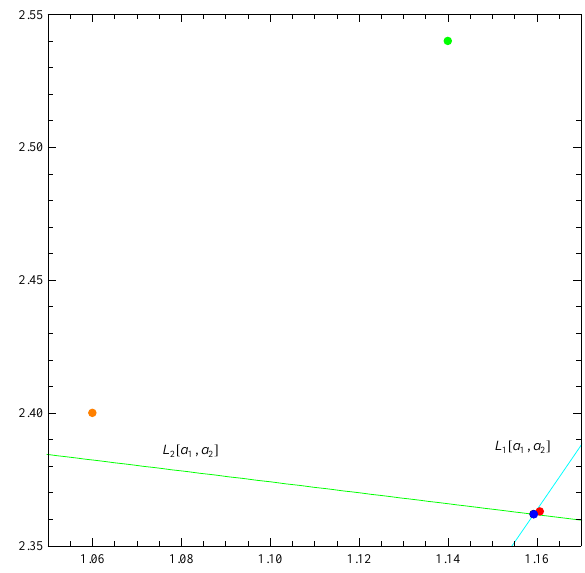
Figure 1. Values of a k and b k after two